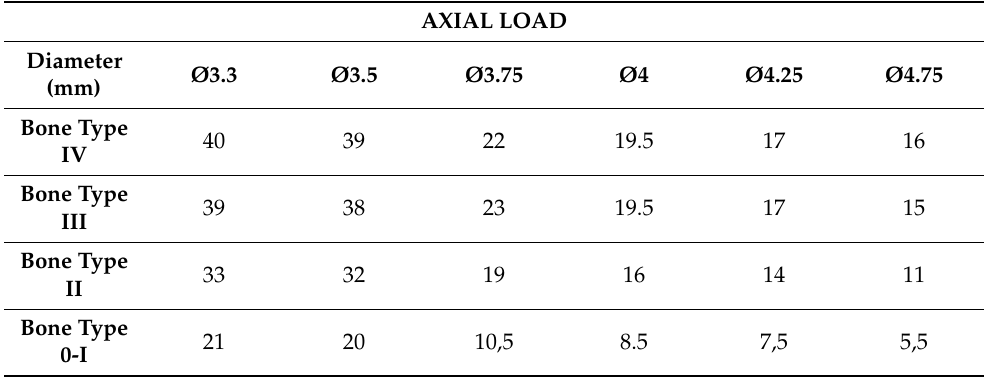
Table 3. Maximum equivalent Von Mises stress (MPa) in bone at 30 ◦ angled load of 200N. AXIAL